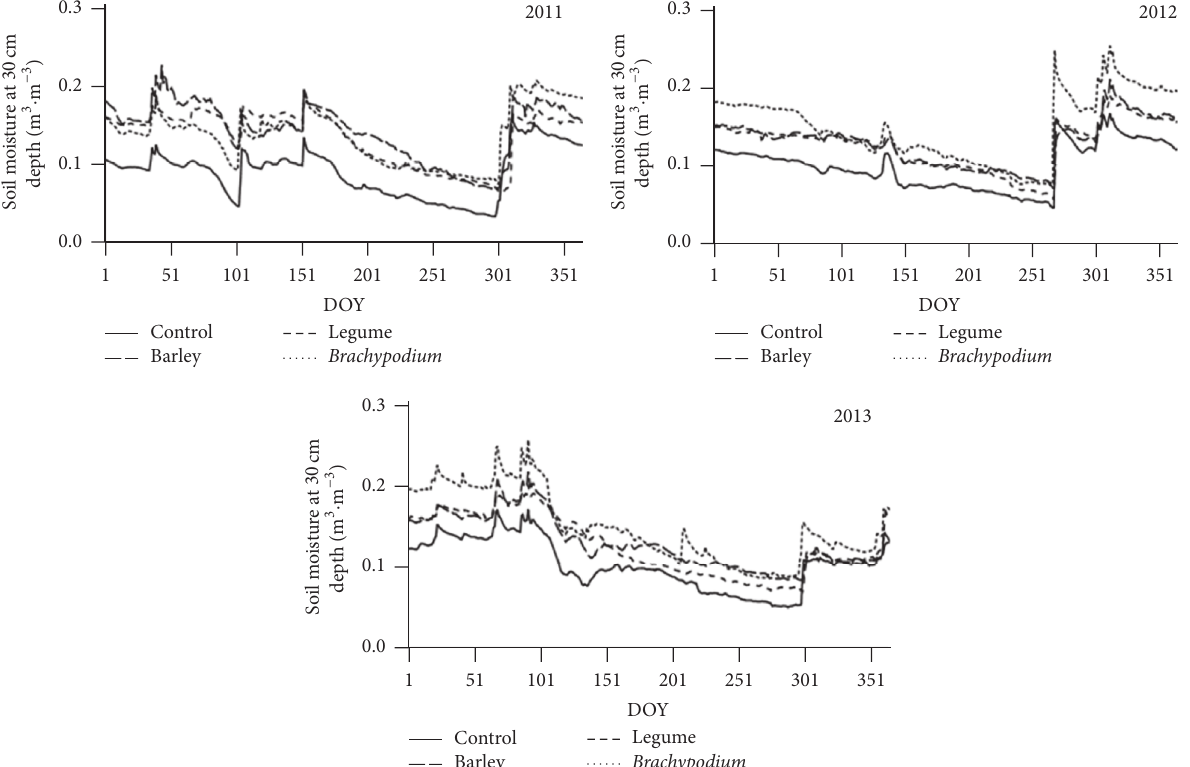
Figure 2: Daily soil moisture (m 3 ⋅ m −3 ) at 30cm depth in 2011, 2012, and 2013 for the four treatments. DOY: day of the year.